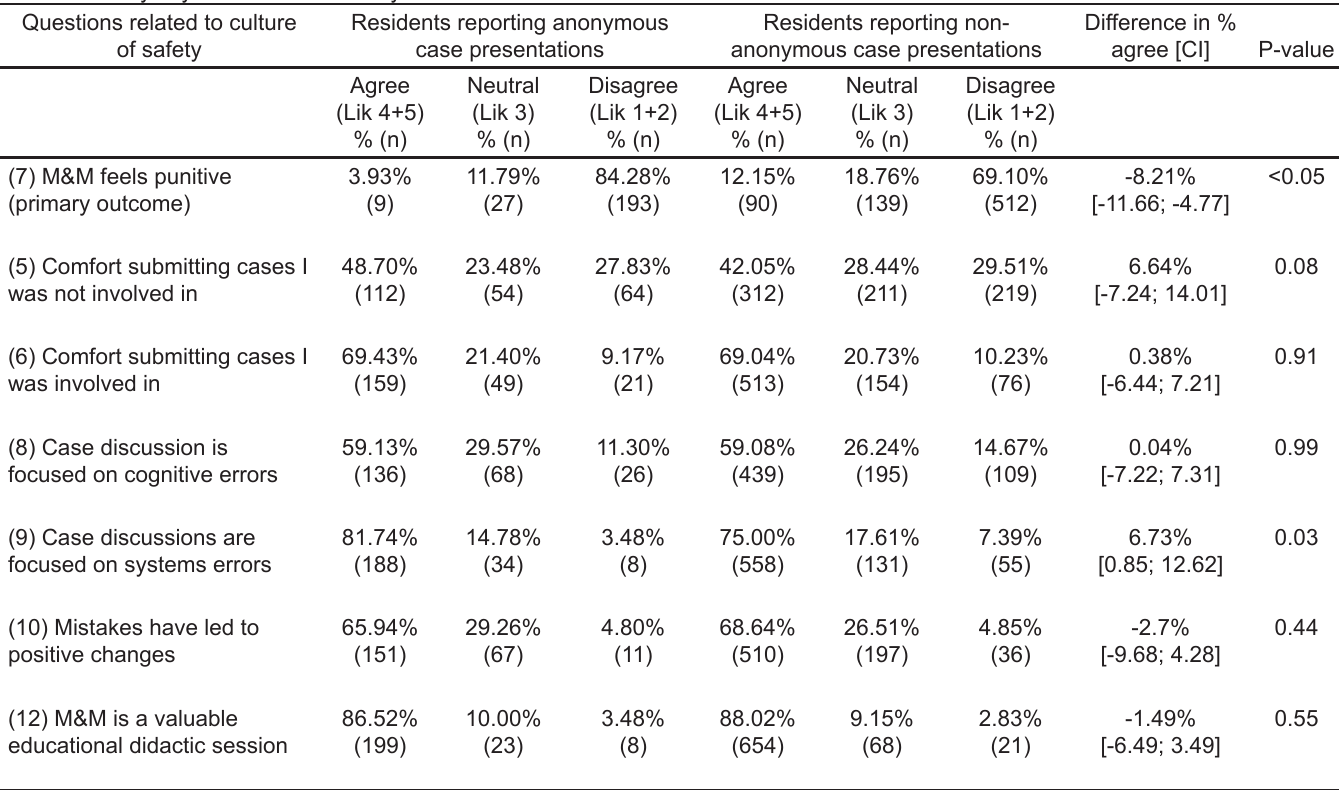
Table 2. Anonymity and culture of safety domains. Questions related to culture